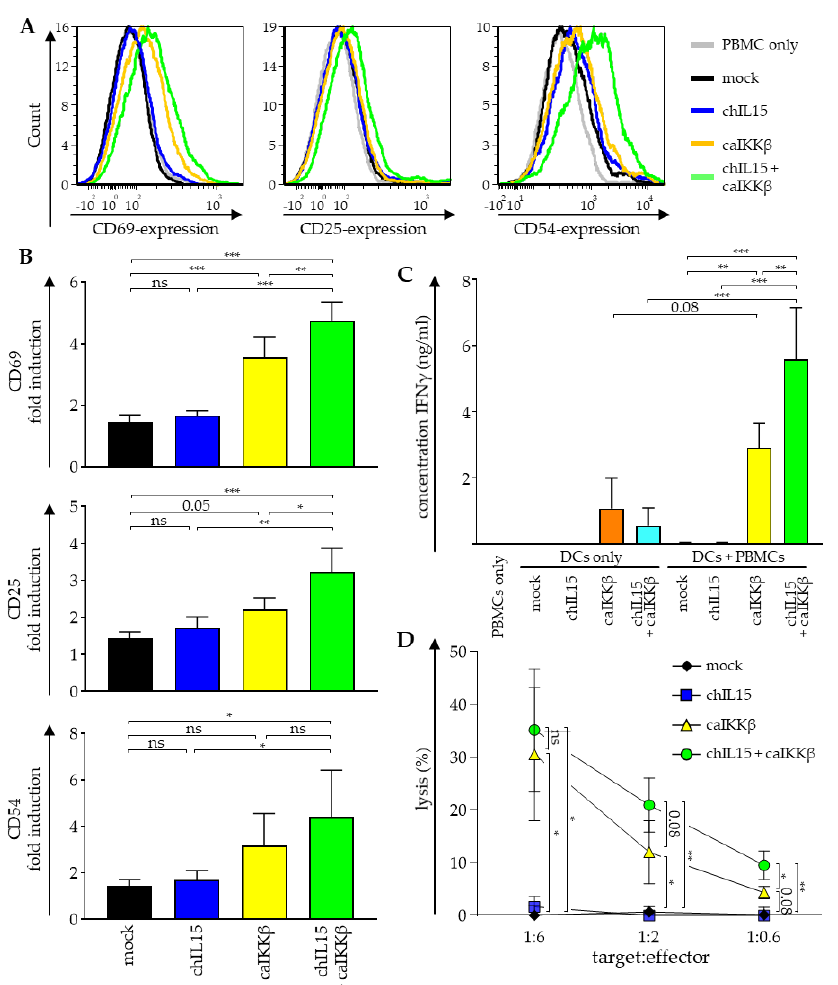
Figure 2. Transfection of DCs with caIKK β combined with chIL15 leads to an improved NK-cell activation. DCs matured with the standard cytokine cocktail were electroporated with RNA encoding caIKK β and chIL15 either alone or in combination. As a control, DCs were mock electroporated. Transfected DCs were co-cultured with autologous peripheral blood mononuclear cells (PBMCs) 2–4 h after electroporation at a ratio of 1:10 (final concentrations 2 × 10 5 DCs/mL and 2 × 10 6 PBMCs/mL). As controls, transfected DCs and PBMCs were cultured alone. Cells were harvested and supernatant was sampled after 48 h of co-culture. ( A ) The expression of surface markers CD69, CD25, and CD54 was determined via flow cytometry on cells negative for CD3 and positive for CD56 (using the gating strategy shown in Supplemental Figure S3). A representative histogram for each activation marker out of three independent experiments is shown. ( B ) The depicted values show the fold upregulation of each surface marker, calculated relative to the mean fluorescence intensity (MFI) of PBMCs cultured in absence of DCs. The average fold induction of three different donors with SD is shown. p values were calculated with a one-way ANOVA and subsequent Tukey test, *** p ≤ 0.001, ** p ≤ 0.01, * p ≤ 0.05, numbers indicate p values of 0.05 < p ≤ 0.1. ( C ) The secretion of IFN γ was measured in the supernatant by Cytometric Bead Array. Average cytokine concentrations with SD are shown from three independent donors. p values were calculated with a one-way ANOVA and subsequent Tukey test, *** p ≤ 0.001, ** p ≤ 0.01, numbers indicate p values of 0.05 < p ≤ 0.1. ( D ) The cytolytic capacity of stimulated cells was determined in a 51 chromium release assay. The K562 cell line was used as a target at the indicated target ratios. Average values with SD of three independent donors, each analyzed in triplicates, are shown. p values were calculated with a one-way ANOVA and subsequent Tukey test, ** p ≤ 0.01, * p ≤ 0.05, numbers indicate p values of 0.05 < p ≤ 0.1. The respective brackets refer to the mock-transfected